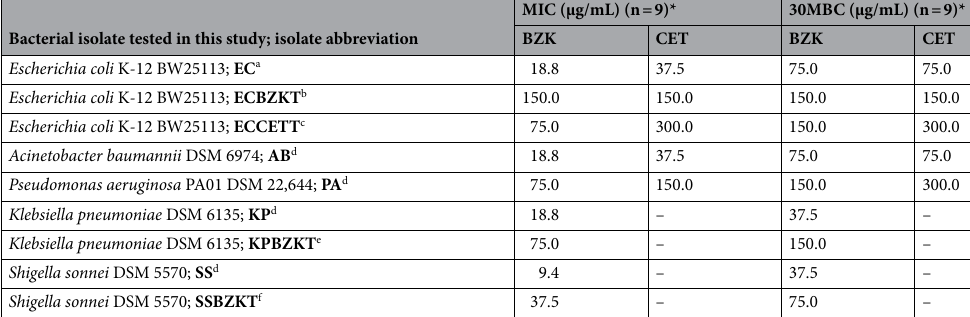
in PI RFU 30min values at EM 620 nm, when we compared live cell suspensions to their identical heat-treated con- trols, the live cell samples unexposed to QACs (0.0 μg/mL QAC) often had some background RFU 30min emission signal between assays. To compensate, we subtracted RFU 30min 0.0 μg/mL QAC value as a calculation adjustment, resulting in ΔRFU Δ30min values to observe accurate increases due to QAC addition (Fig. S1). To distinguish QAC-susceptible from tolerant phenotypes among stationary phase E. coli cell suspensions